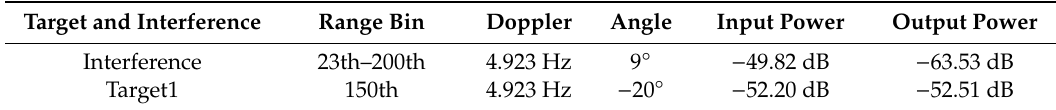
Figure 6. The cancellation results for radio interference: ( a ) Range-Doppler spectrum before suppression; ( b ) Range-Doppler spectrum after suppression; ( c ) Doppler profile after suppression. Table 1. Target and interference parameters.